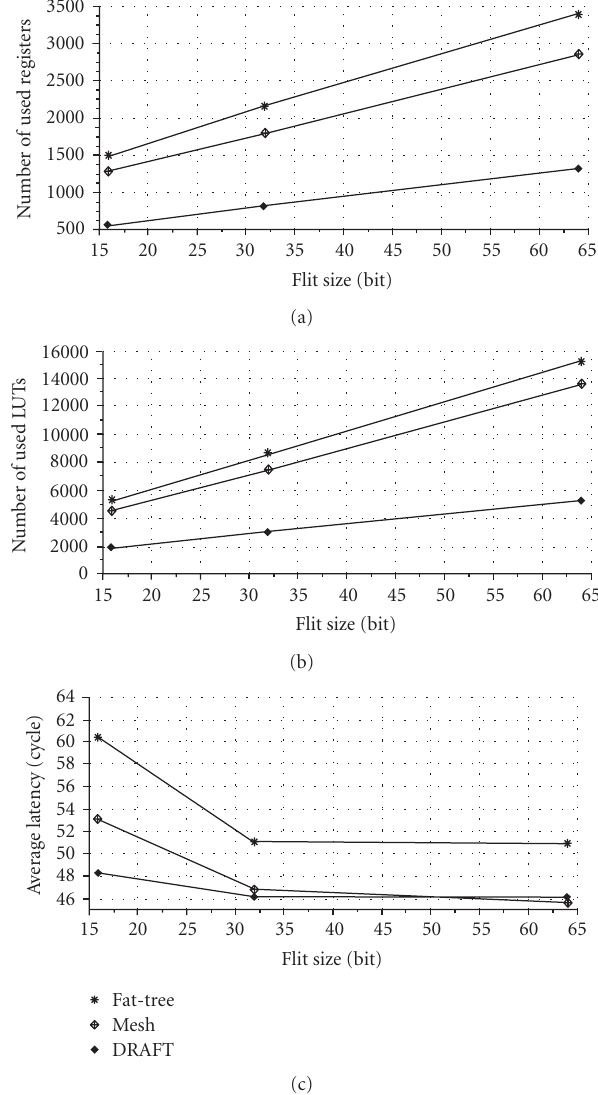
Figure 15: Influence of the flit sizes over the hardware resources (registers (a) and LUTs (b)) and the latencies (c) with a data rate of 400 Mbit/s per